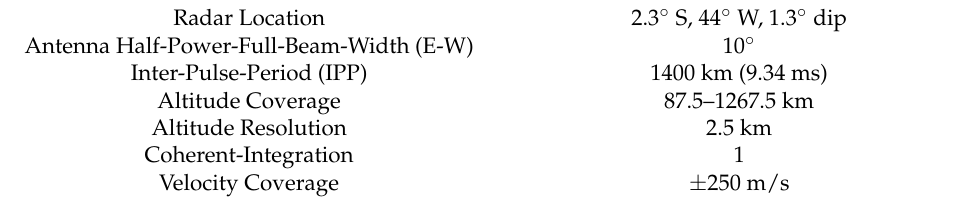
Table 1. Radar specifications and